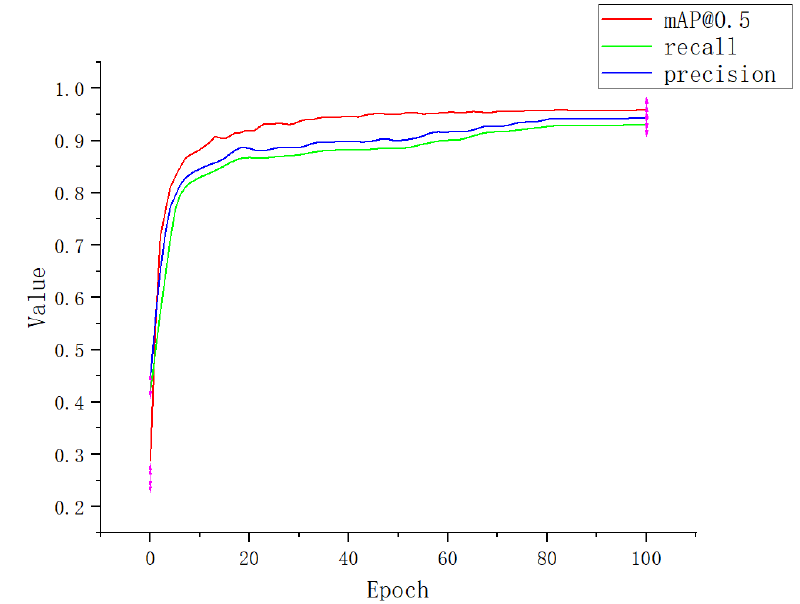
Figure 10. Performance index curve.